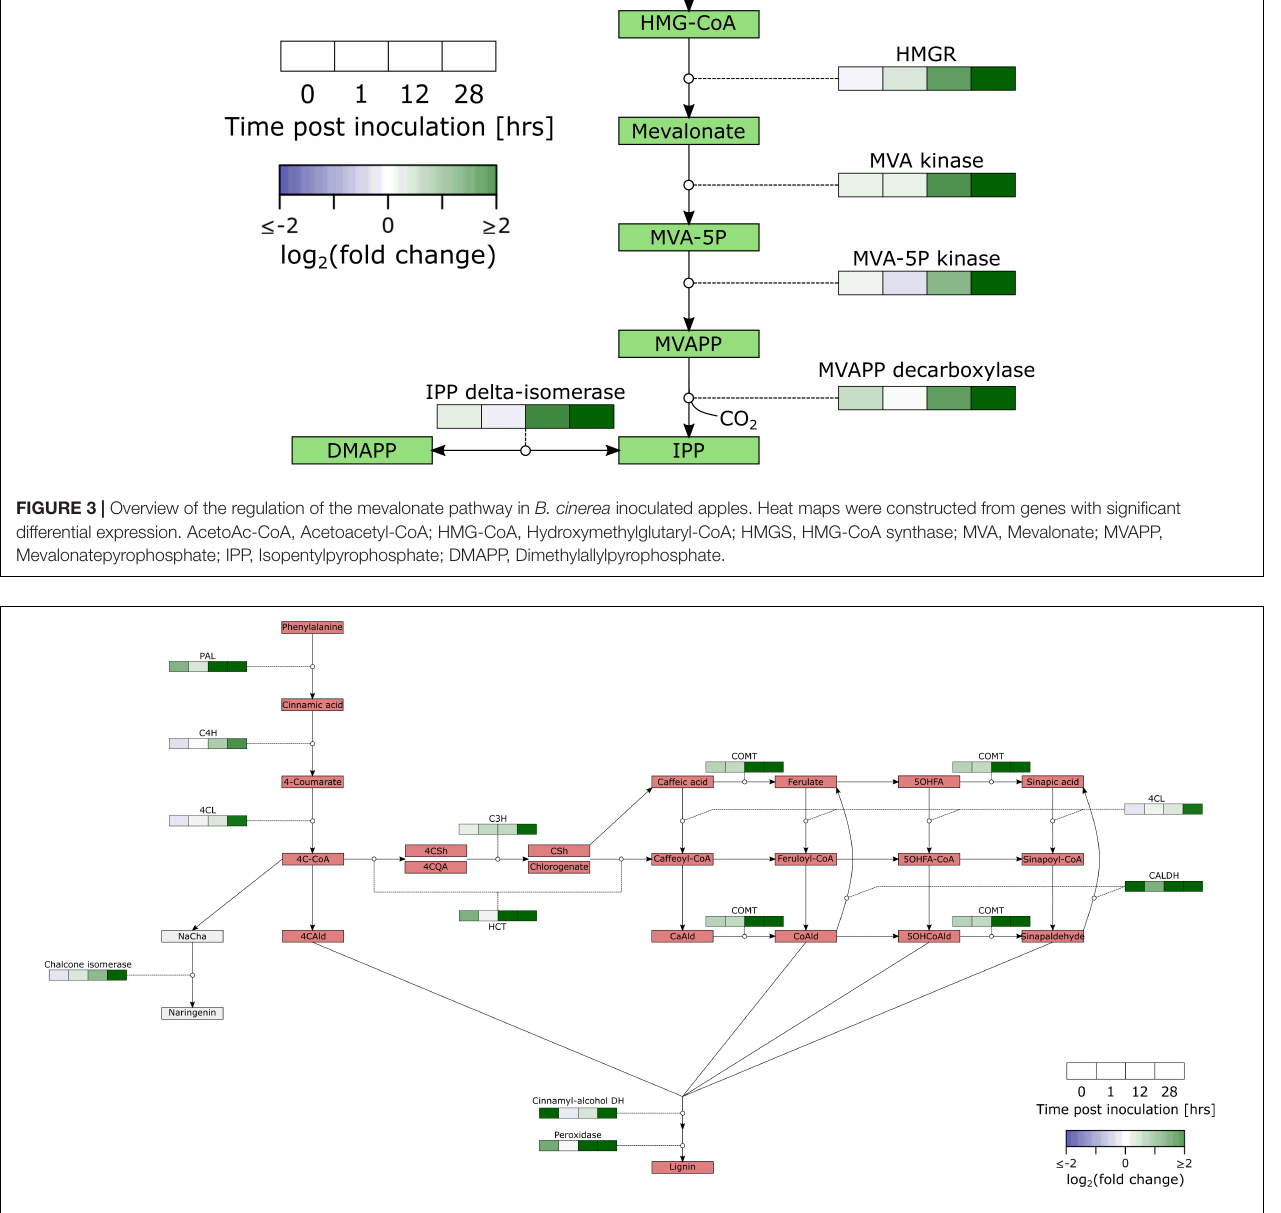
FIGURE 4 | Overview of the regulation of the phenylpropanoid pathway in B. cinerea inoculated apples. Heat maps were constructed from genes with significant differential expression. PAL, Phenylalanine ammonia-lyase; C4H, Trans-cinnamate 4-monooxygenase; 4CL, 4-Coumarate:CoA ligase; 4C-CoA, 4-Coumaroyl-CoA; C3H, 4-Coumarate 3-hydroxylase; HCT, Hydroxycinnamoyl-CoA shikimate:quinate hydroxycinnamoyl-transferase; COMT, Caffeic acid/5-hydroxyferulic acid O-methyltransferase; CALDH, Coniferyl-aldehyde dehydrogenase; 4CAld, 4-Coumaraldehyde; NaCha, Naringenin chalcone; 4CSh, 4-Coumaroyl shikimic acid; 4CQA, 4-Coumaroyl quinic acid; CSh, Caffeoyl shikimate; CaAld, Caffeylaldehyde; CoAld: Coniferaldehyde; 5OHFA, 5-Hydroxyferulic acid; 5OHCoAld, 5-Hydroxyconiferylaldehyde. Another class of secondary metabolic compounds are alkaloids. This is a diverse group of nitrogen containing molecules, often with a function in plant defense. Our expression set suggests that biosynthesis of tropane alkaloids is upregulated in B. cinerea infected tissue. ARGININE DECARBOXYLASE (AGD) was significantly upregulated (2/2). AGD converts Arginine into agmatine, which can be further converted into putrescine and finally tropinone. Our data contained 9 DEGs for TROPINONE REDUCTASE I (TR-I; 16 genes) which reduces tropinone to tropine.